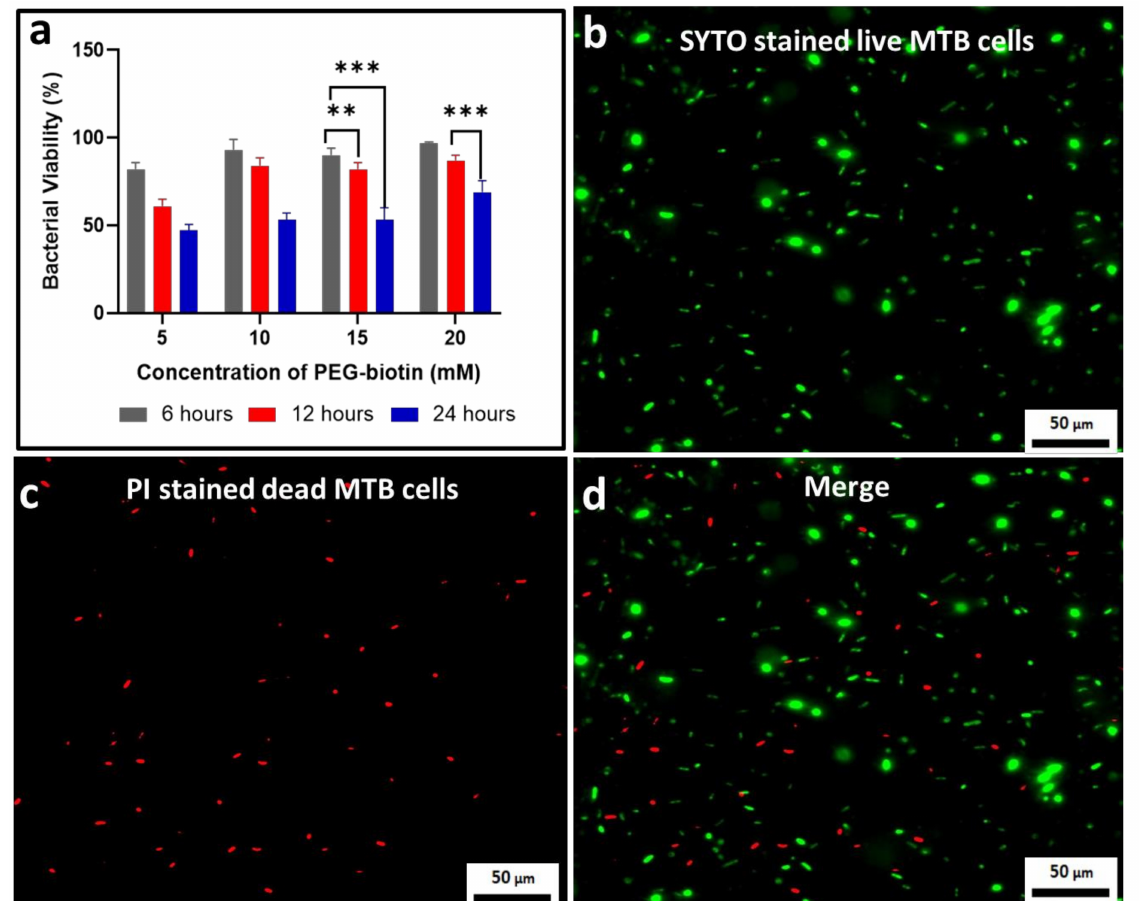
Figure 4. Assessment of bacterial viability. ( a ) Quantification of the percentage of bacterial viability where MTB was treated with different concentrations of PEG–biotin (5, 10, 15, and 20 mM) after different time intervals (6, 12, and 24 h). Results indicate that a higher concentration of PEG–biotin (20 mM) kept the bacteria alive even after long incubation times. Data are presented as mean ± SD, n = 3. Statistical significance (with p < 0.01 and p < 0.001) is indicated with ** and ***, respectively, for datasets that are significantly different between 6, 12, and 24 h. ( b ) Microscopic fluorescent live/dead images for live bacteria stained with SYTO stain; ( c ) bacterial cells stained with propidium iodide; ( d ) merged images for live/dead bacterial